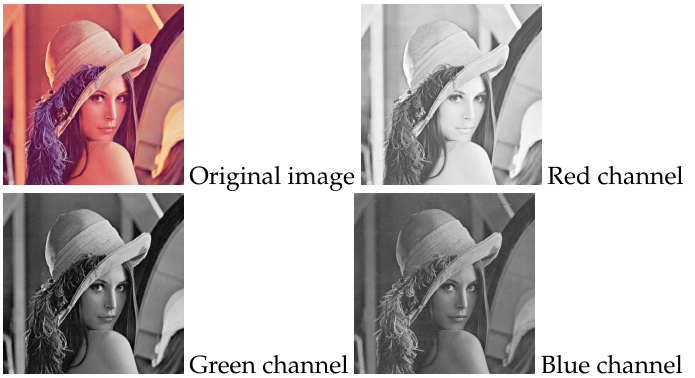
Figure 9. The color image Lena and its red channel, green channel, and blue channel.